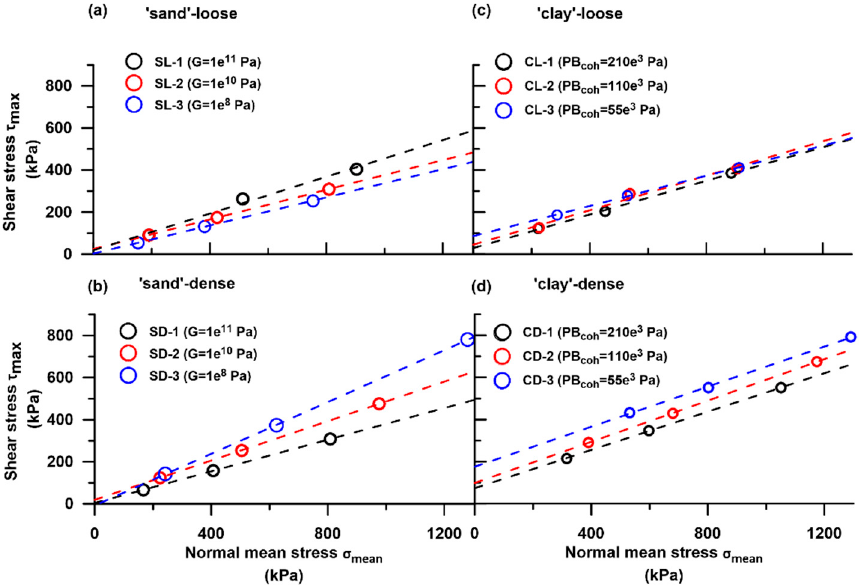
Figure 6. Modified Mohr–Coulomb failure envelopes for ( a ) loose ’sand’ ( b ) dense ’sand’ ( c ) loose ’clay’ and ( d ) dense ’clay’ samples. Circles denote the differential peak shear strength measured in each test under the appropriate normal stress.